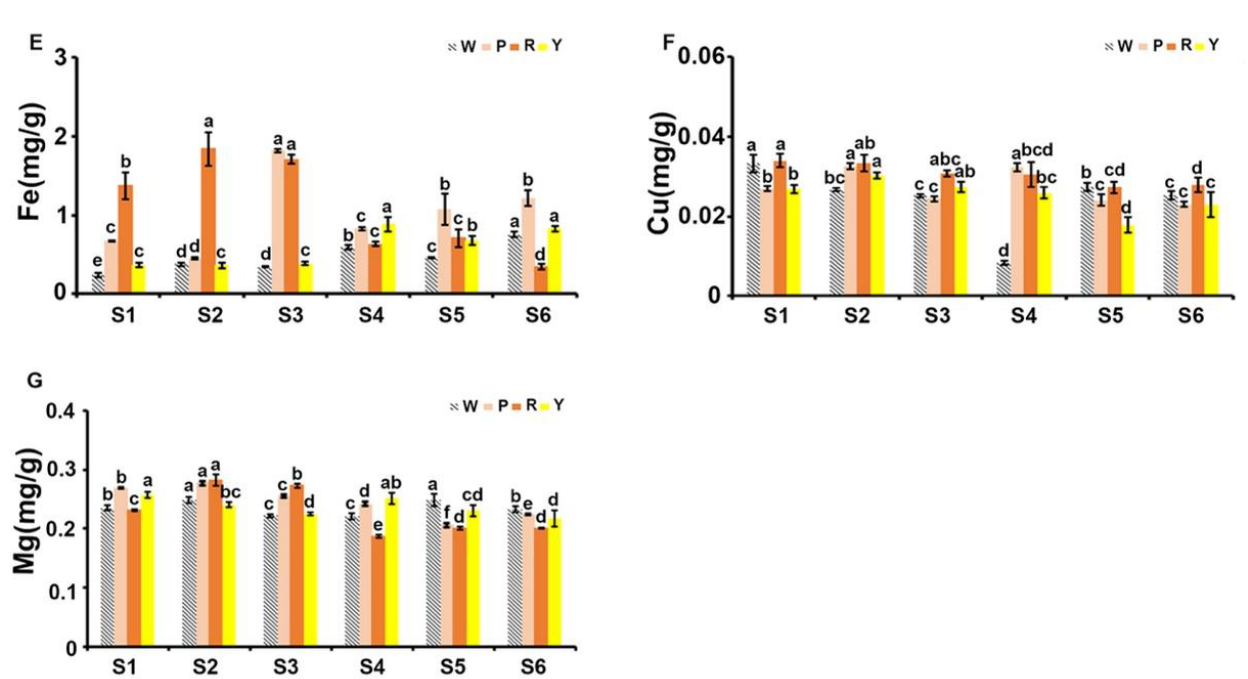
Figure 4. The content of metal ions in ray florets of four colored chrysanthemums. ( A – G ) The content detection of K + , Ca 2+ , Na + , Zn 2+ , Fe 3+ , Cu 2+ , and Mg 2+ in ray florets of four colored chrysanthemums at six flowering stages. Data are shown as the mean ± standard error of the mean, based on more than three replicates. Different letters indicate significant differences at p < 0.05 according to the Duncan’s multiple range test.